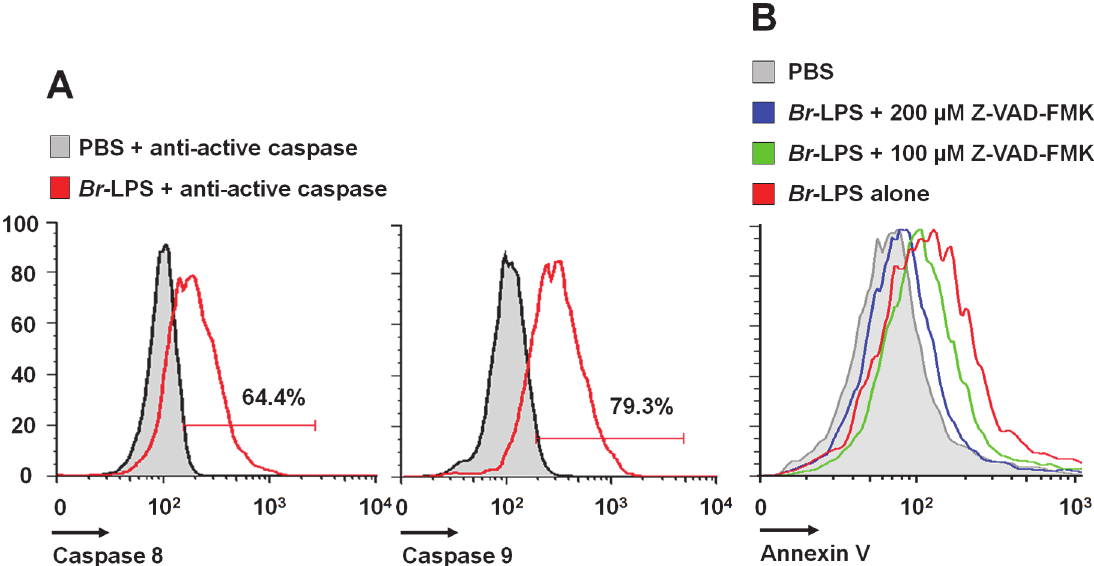
Fig 12. Br- LPS induces activation of caspase 8 and 9 in PMNs. (A) Heparinized blood was incubated with 0.3 pmol/mL of Br- LPS or PBS for 30 minutes and stained with anti-active caspase 8 or anti-active caspase 9. PMNs population was analyzed by each caspase marker (B) Heparinized blood samples were treated with Z-VAD-FMK or PBS for 1 hour and then incubated with Br -LPS (1.5 pmol/mL) for 2 hours. PMNs population was analyzed by Annexin V. Geometric means of histograms are displayed as relative units. Experiments were repeated at least three